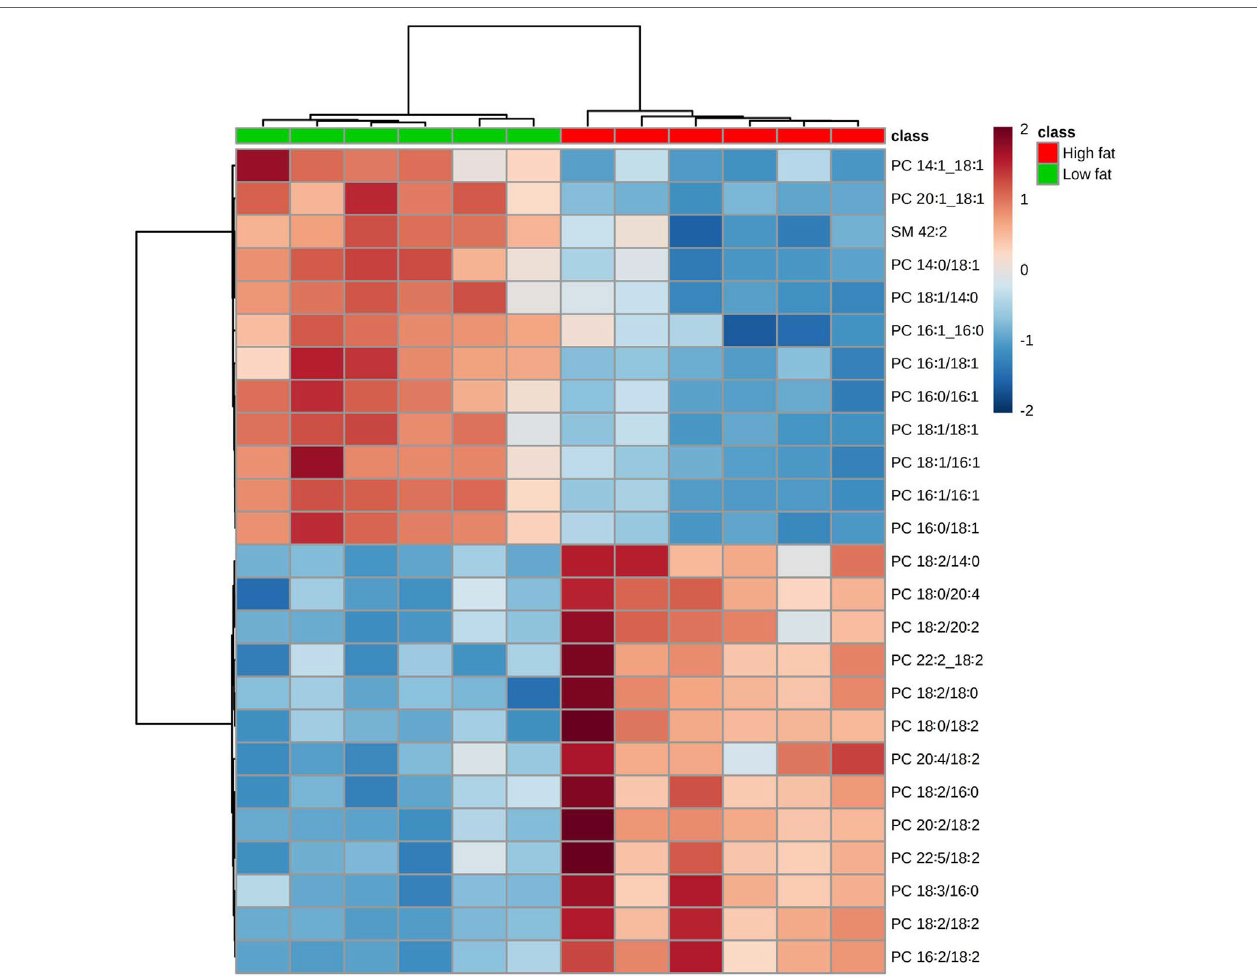
FigUre 2 | Hierarchical clustering heatmap analysis of phosphatidylcholine (PC) lipids in the primary tumor of Lewis lung carcinoma from mice fed the AIN93G diet or the high-fat diet. Each colored cell on the map corresponds to a concentration value. The top 25 lipid species from the two diet groups are presented and ranked by t -tests to retain the most contrasting patterns. Values are measured by Euclidean distance with a Ward clustering algorithm ( n = 6 per group). * p ≤ 0.05 for each